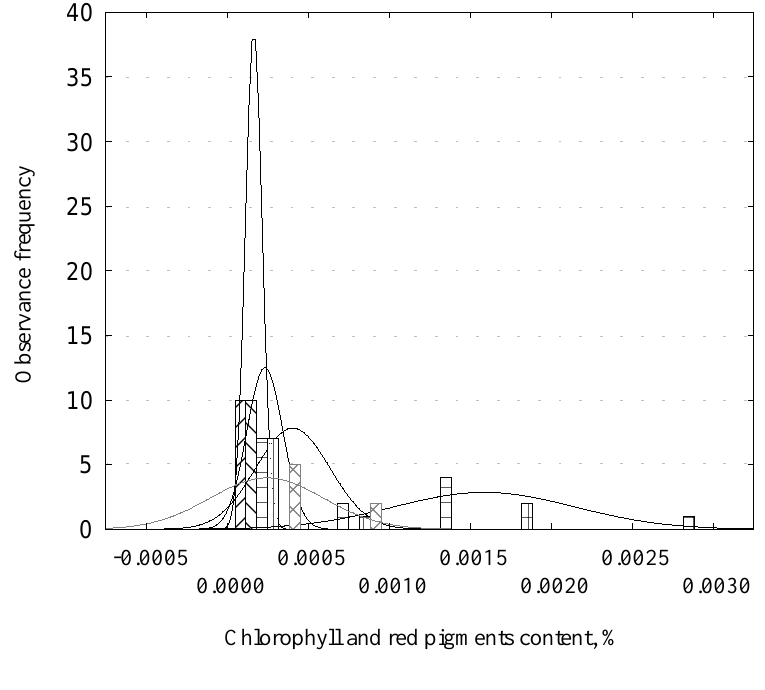
Fig. 7. Dependence of chlorophyll and red pigments content in rutin samples on carbon